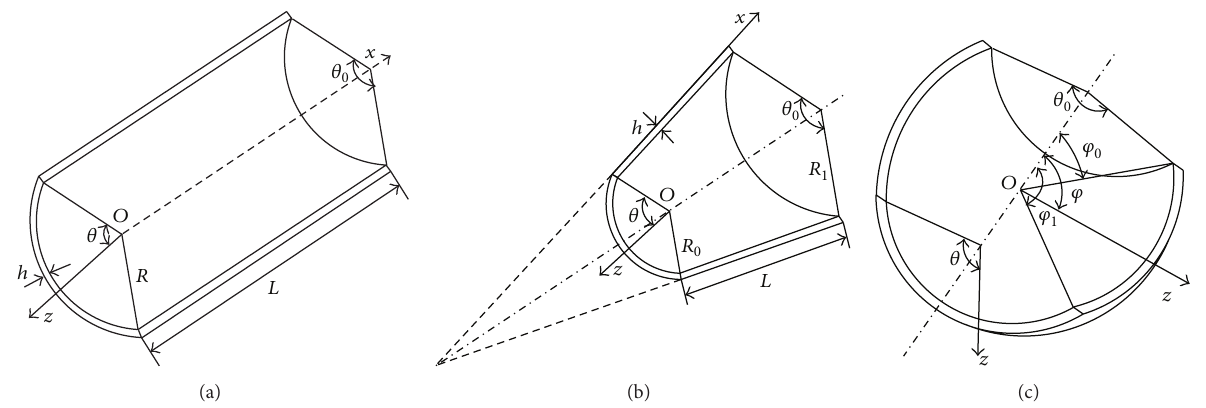
Figure 2: Definition of shell coordinate system: (a) cylindrical shell; (b) conical shell; and (c) spherical shell.